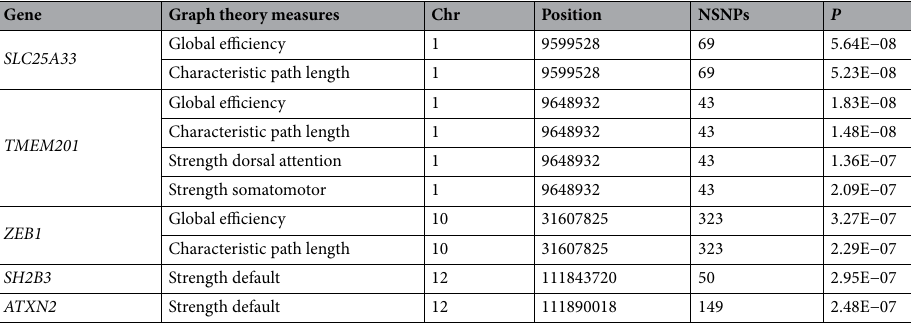
Table 3. Gene-based association analysis identified five significant gene-level associations for brain functional network measures. Gene-based association analysis was performed via MAGMA 18 , which uses 1000G reference panel for calculation of LD between the SNPs and gene coordinates based on NCBI build 37. Only genes that passed the Bonferroni correction ( p < 4.56 × 10 –7 ) are reported here. Abbreviations: Chr, chromosome; NSNP, number of single nucleotide polymorphisms. SLC25A33 , Solute Carrier Family 25 Member 33; TMEM201 , Transmembrane Protein 201; ZEB1 , Zinc Finger E-Box Binding Homeobox 1; SH2B3 , SH2B Adaptor Protein 3; ATXN2 , Ataxin